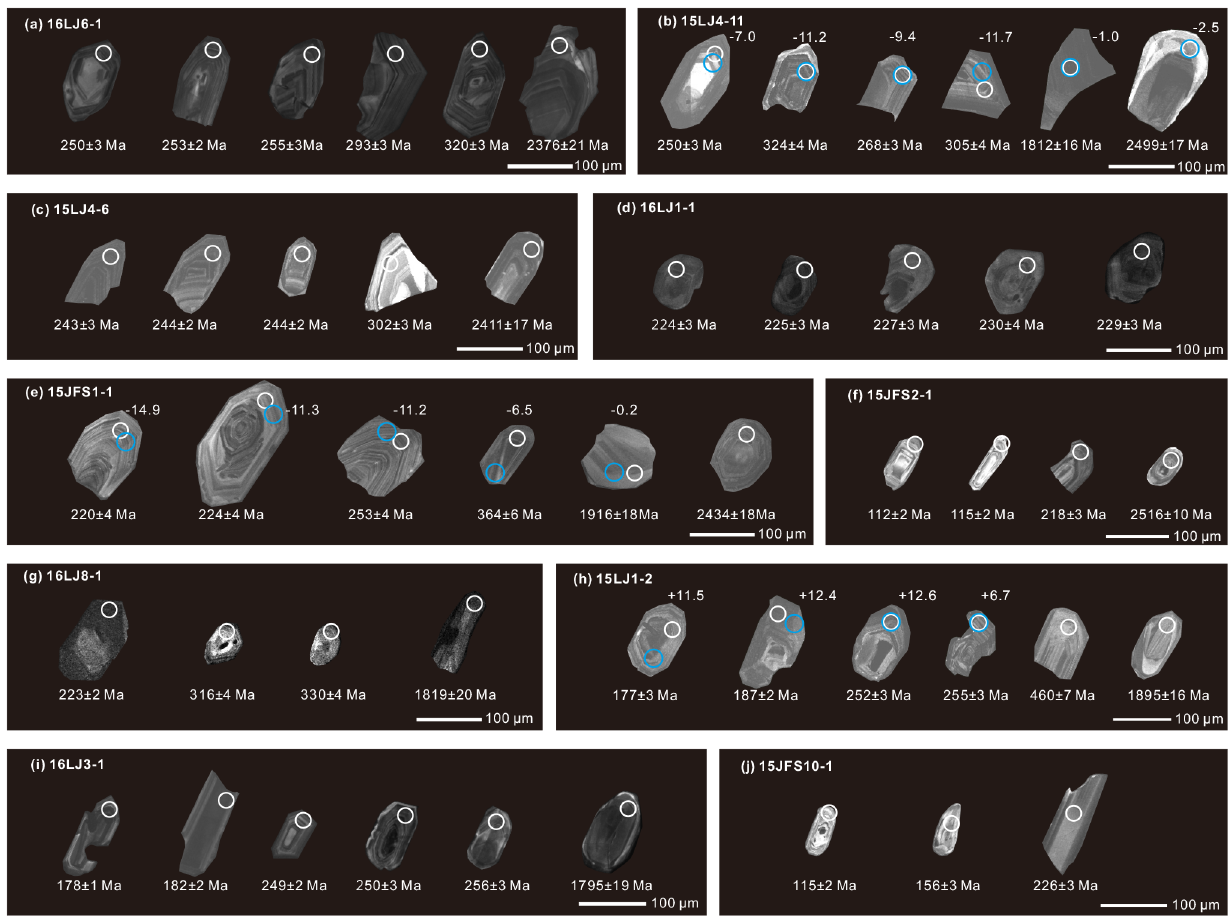
Figure 8. Cathodoluminescence (CL) images of selected zircon grains from early Mesozoic strata. White circles indicate the locations of U–Pb dating analyses, and blue circles show the locations of in situ Hf analyses. Values under and above the images indicate zircon U–Pb ages and measured ε Hf (t) values,